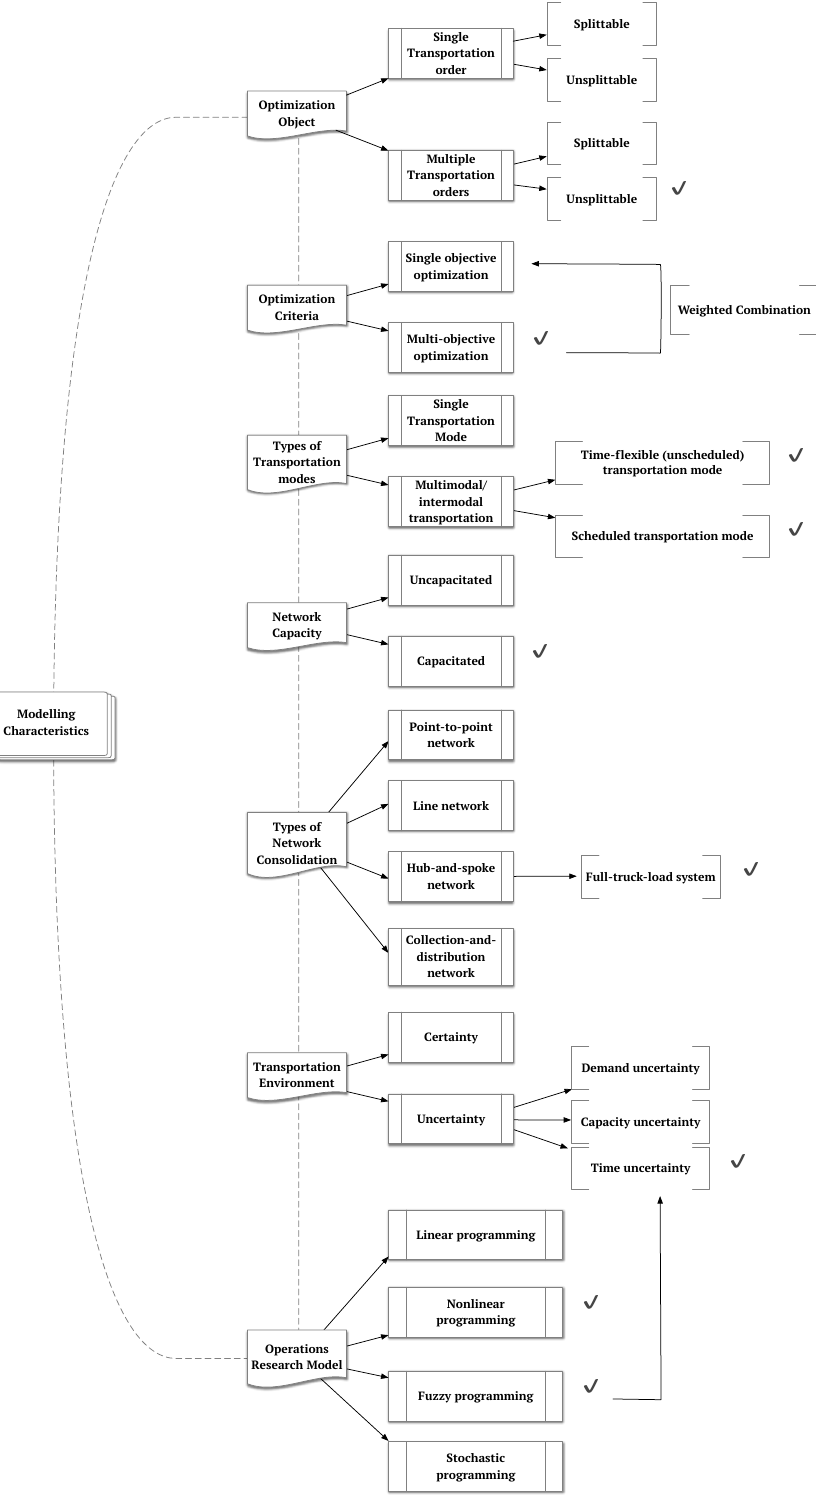
Figure 9. Modelling characteristics of the freight routing